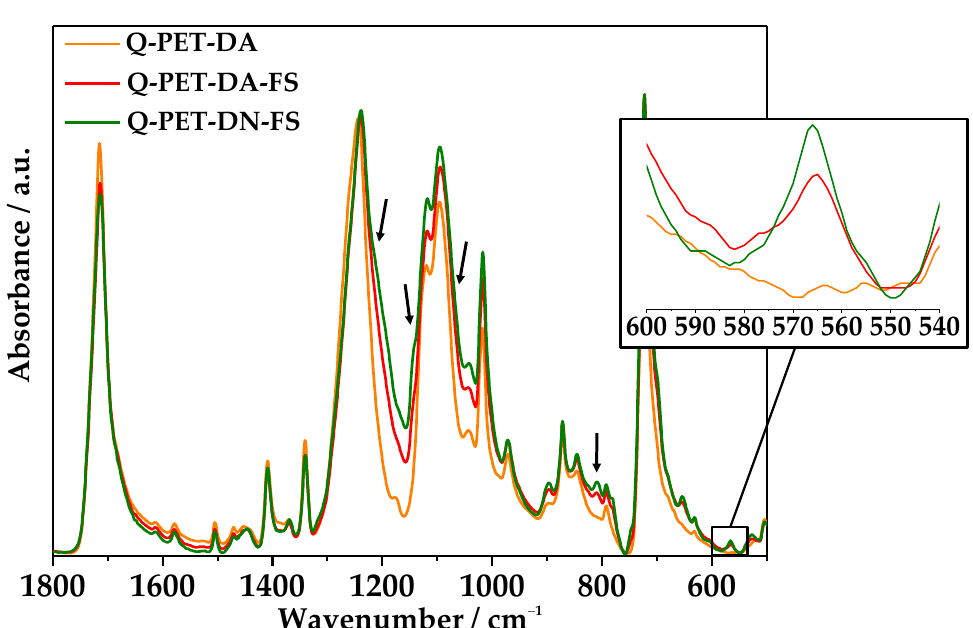
Figure 7. ATR-FTIR spectra of the surfaces after the fluorination step with PFOTCS. The ATR-FTIR spectrum of Q-PET-DA is included for comparison.